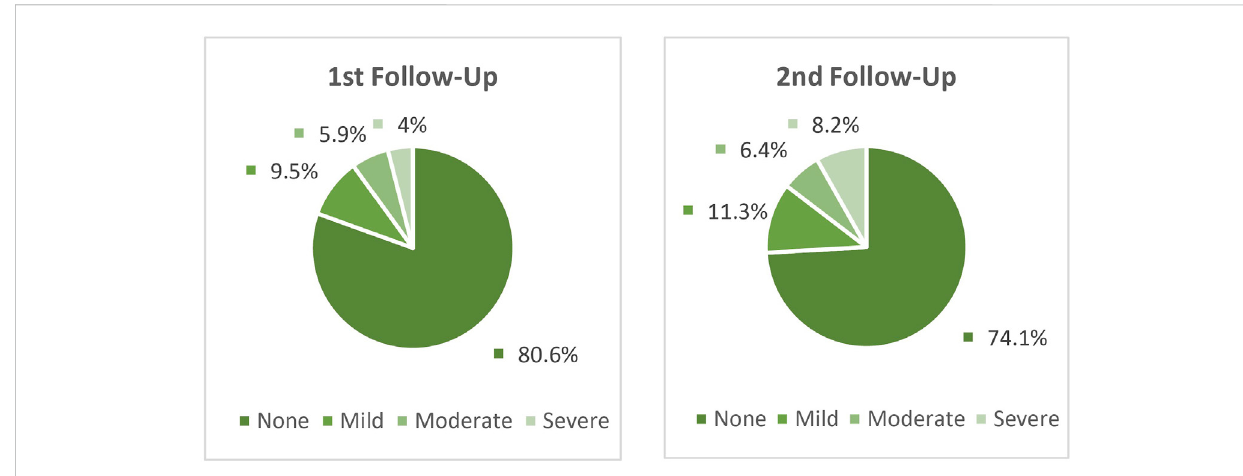
FIGURE 2 Symptoms severity of patients referred to MMT centers at fi rst and second follow-ups (n = 452); None, no symptom; Mild, one to two symptoms; Moderate, three symptoms; Severe, ≥ 4